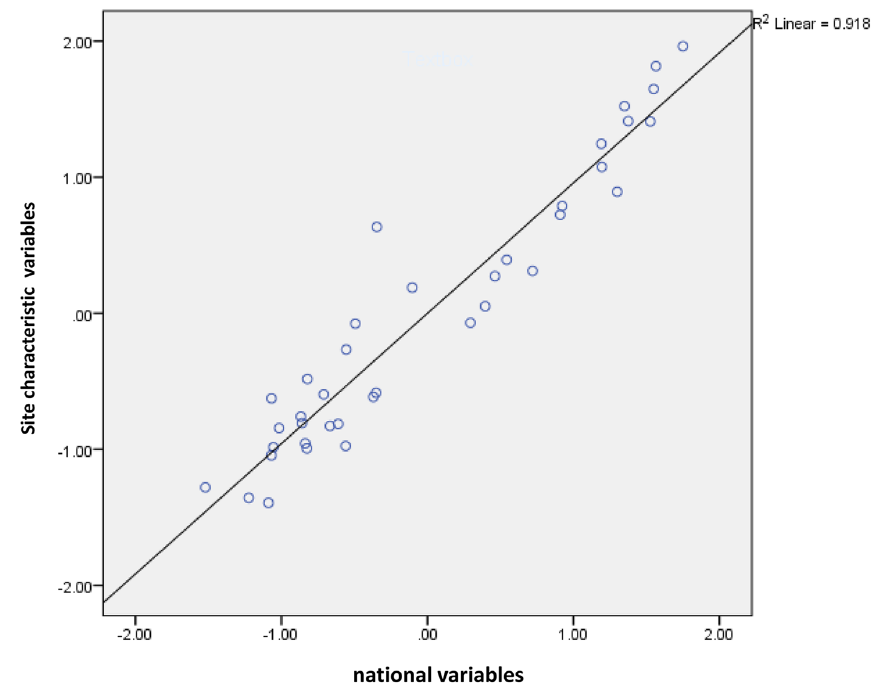
Fig. 11 The liner relation between the national variables and the site